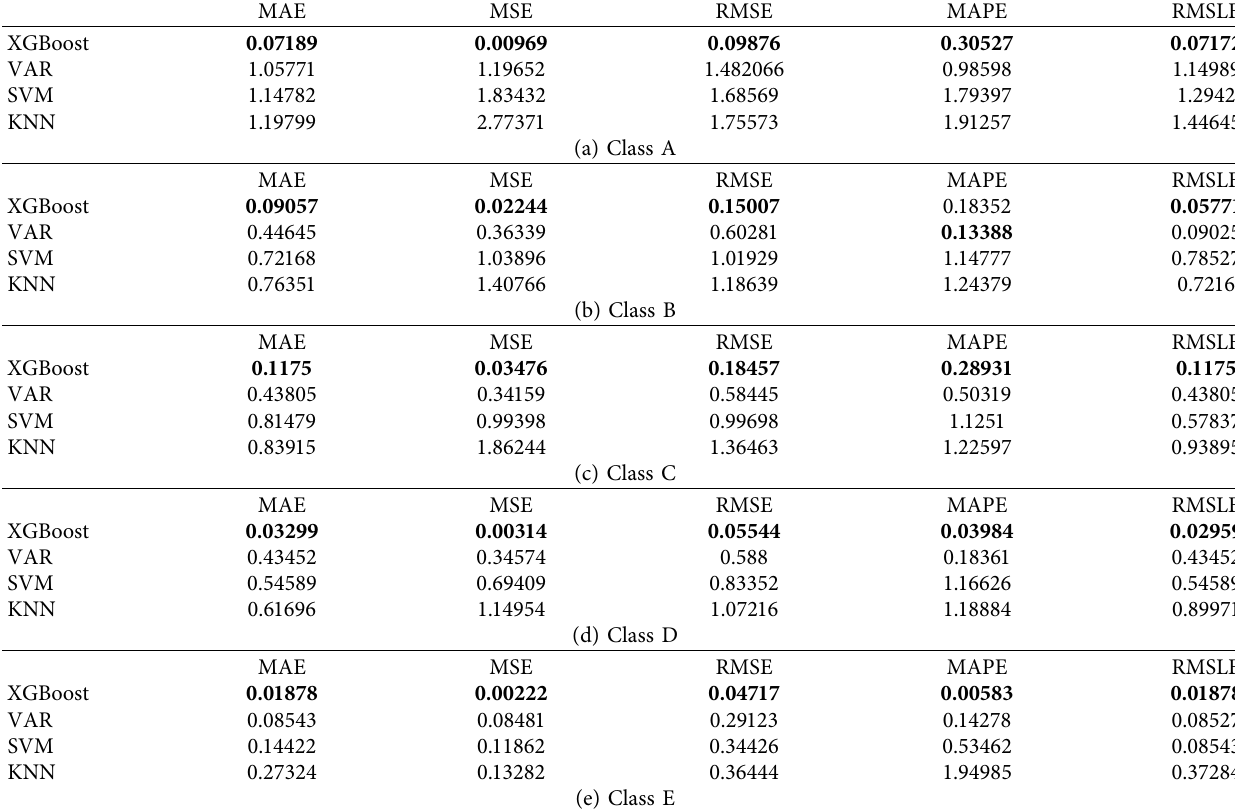
Table 8: Machine learning for historical data with weekends data evaluation